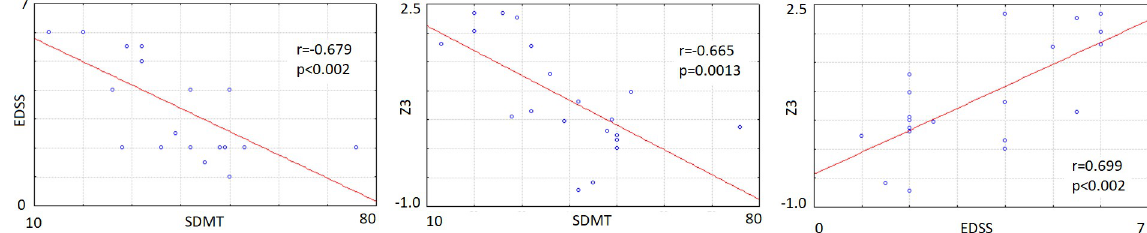
Fig 4. Scattergrams for the significant correlations between EDSS, SDMT and Z3 variables. Abbreviations:Z3: Z-score of combined variables (reaction time, P3 latency and ERD latency), SDMT:Symbol Digit Modality Test and EDSS: Expanded Disability Status Scale.